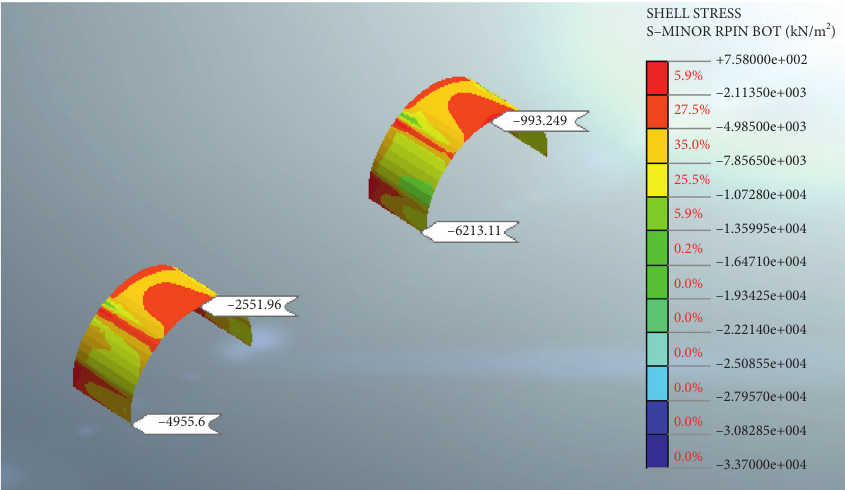
Figure 22: Initial lining stress distribution of single-side guide pit method.